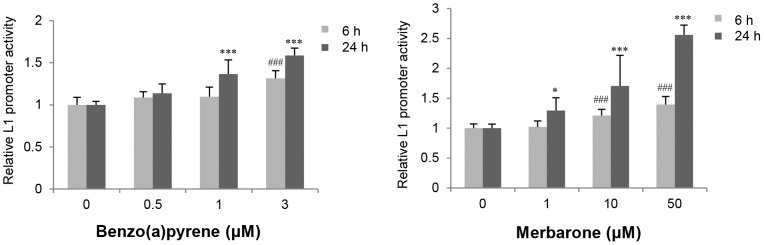
Effects of benzo[a]pyrene and merbarone on L1 promoter activity in HeLa cells.L1 promoter activity 6 and 24 hours after treatment was evaluated by the luciferase reporter gene assay. Data are represented as the average ratio (± SD) of the L1 promoter activity in the presence of the test compound relative to that in the presence of the vehicle control from two independent experiments (in quadruplicate; n = 8). Statistically significant differences as compared with the vehicle control for 6-hour and 24-hour treatments are indicated by *and #, respectively (*p<0.05; ***or ###, p<0.001).